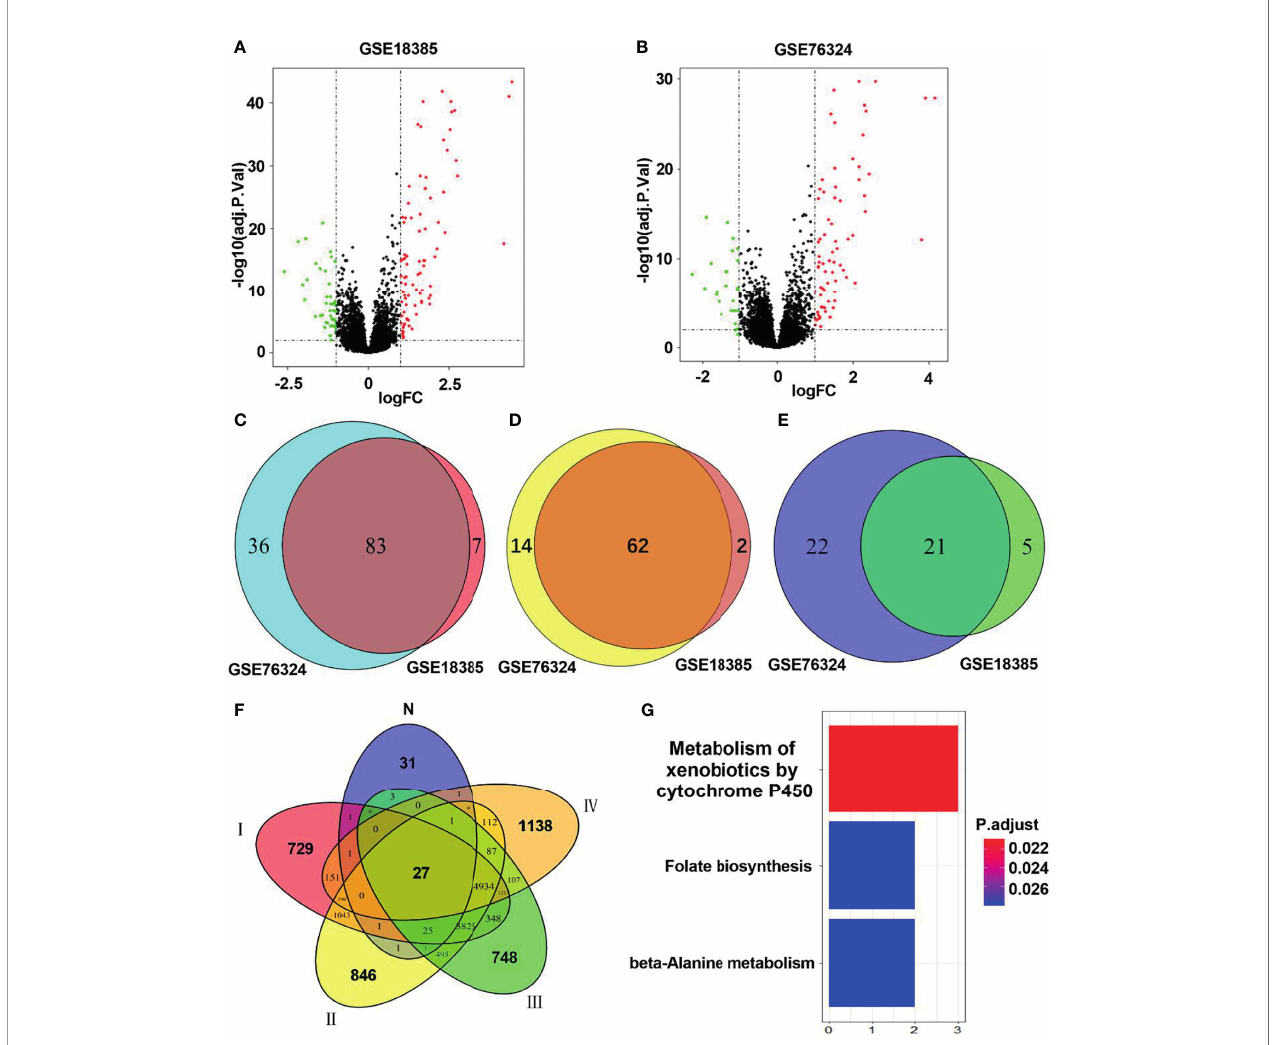
FIGURE 2 | Identi fi cation of hub smoking-related genes (SRGs). (A, B) Volcano plots of differentially expressed genes in the GSE18385 and GSE76324 cohorts. Log2 (FC) vs. -log10 (adj.P.Val) for differentially expressed genes. Red and blue dots represent upregulated and downregulated genes, respectively (log2|FC| > 1, adj.P.Val < 0.05). (C) Venn diagram of SRGs in GSE18385 and GSE76324. (D) Venn diagram of upregulated differentially expressed genes in GSE18385 and GSE76324. (E) Venn diagram of downregulated differentially expressed genes in GSE18385 and GSE76324. (F) Venn diagrams plotted to showcase overlaps between the 83 SRGs and TCGA dataset. N represents 83 SRGs from healthy smokers, while I, II, III and IV represent clinical stages I, II, III and IV among smokers with lung cancer, respectively. (G) Signi fi cantly enriched Kyoto Encyclopedia of Genes and Genomes pathways corresponding to the 27 hub